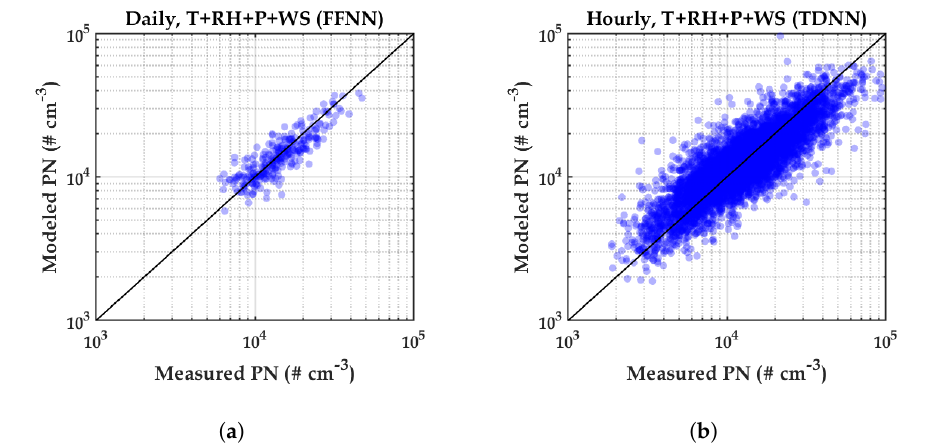
Figure 10. Scatter plot between PN measurement and PN estimation using four measured meteorological variables (T, RH, P, and WS). ( a ) Daily. ( b ) Hourly.